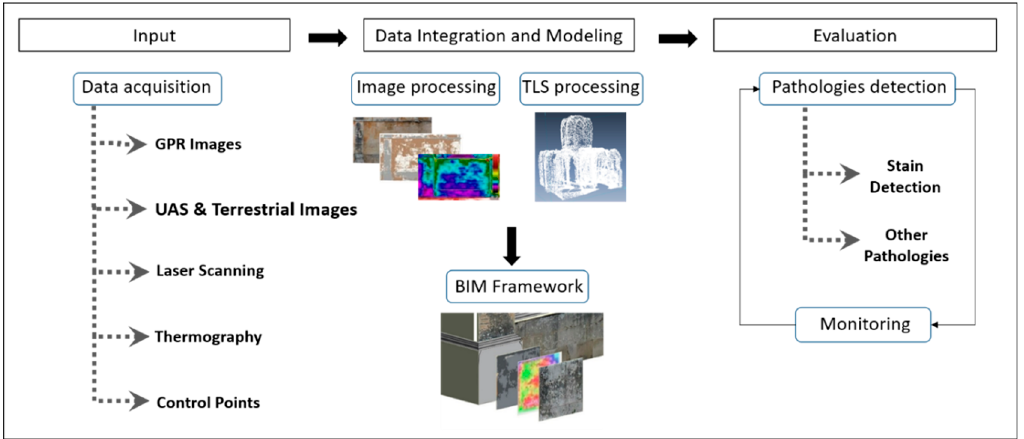
Figure 1. General overview of the methodological approach employed in the project “Heritage-3DIM: Modeling and Monitoring Cultural Heritage with 3D Geospatial